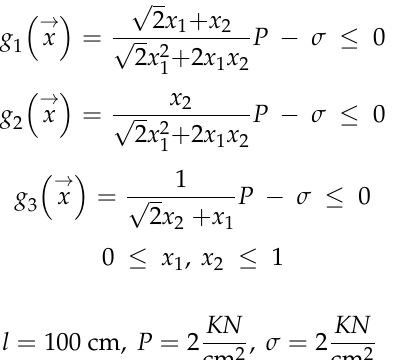
Figure 5. Three-bar truss structure [42]. Table 9. Results of solving the welded beam design problem.